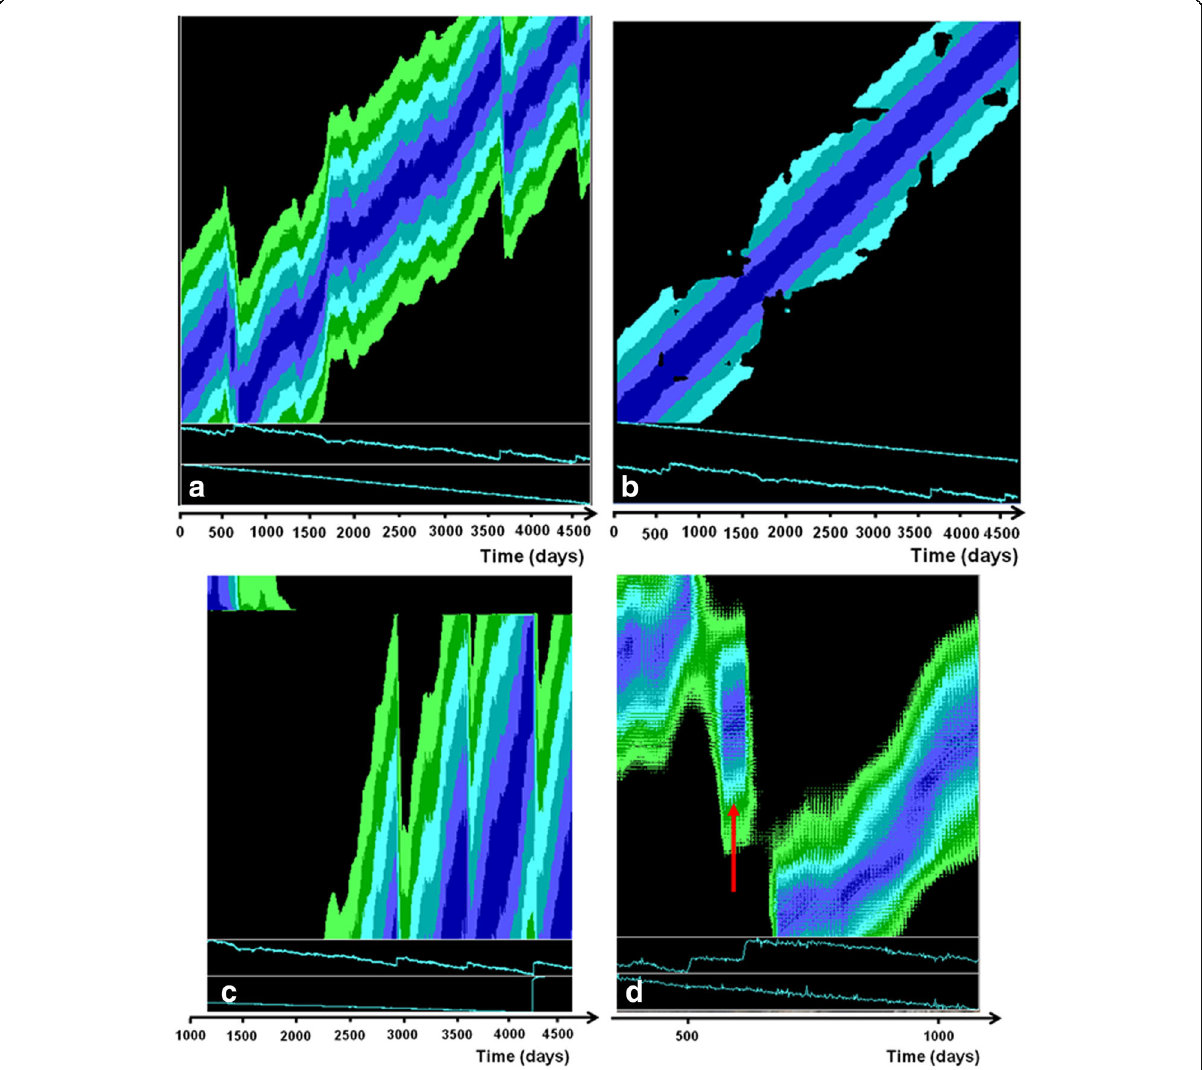
Fig. 20 Synchronisation between signals from station PAWA on the the North Island with KAIK signals on the South Island (see Fig. 11a). a Cross recurrence plot between PAWA_e and KAIK_e. PAWA_ upper frame, KAIK_e signal lower frame ( b ) Joint recurrence plot between PAWA_e and KAIK_e. KAIK_e signal upper frame, PAWA_e signal lower frame. c Cross recurrence plot between signals PAWA_e (top frame) and KAIK_e (lower frame) coving the period of the Kaik ō ura event. d Zoom into early part of Fig. 20a showing the steep LOS (red arrow) accompanying a major displacement